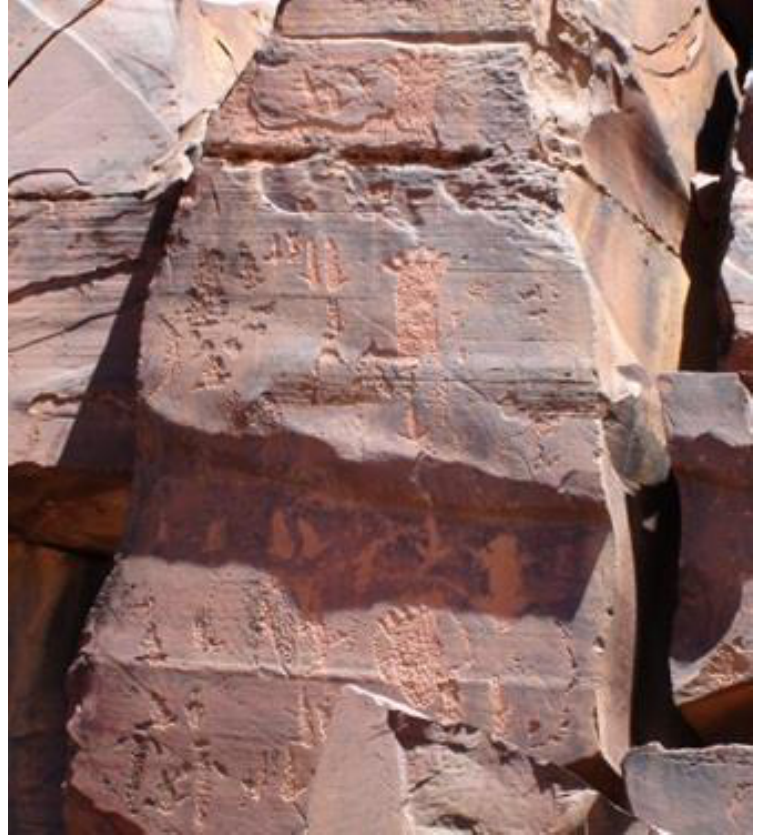
Figure 23. Pecked human feet, Flinders Ranges, South